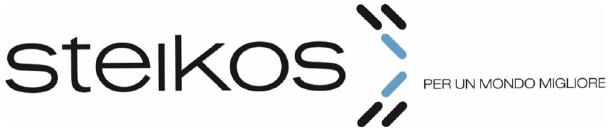
The logo consists of two corporate colors: black and blue and the latter will be determined by the code Pantone 542 C (blue). This color inspires con fi dence in dealing with water, denotes freshness, a natural color image which is clean. The black suggests strength, power, authority, courage, seriousness, stability and elegance.